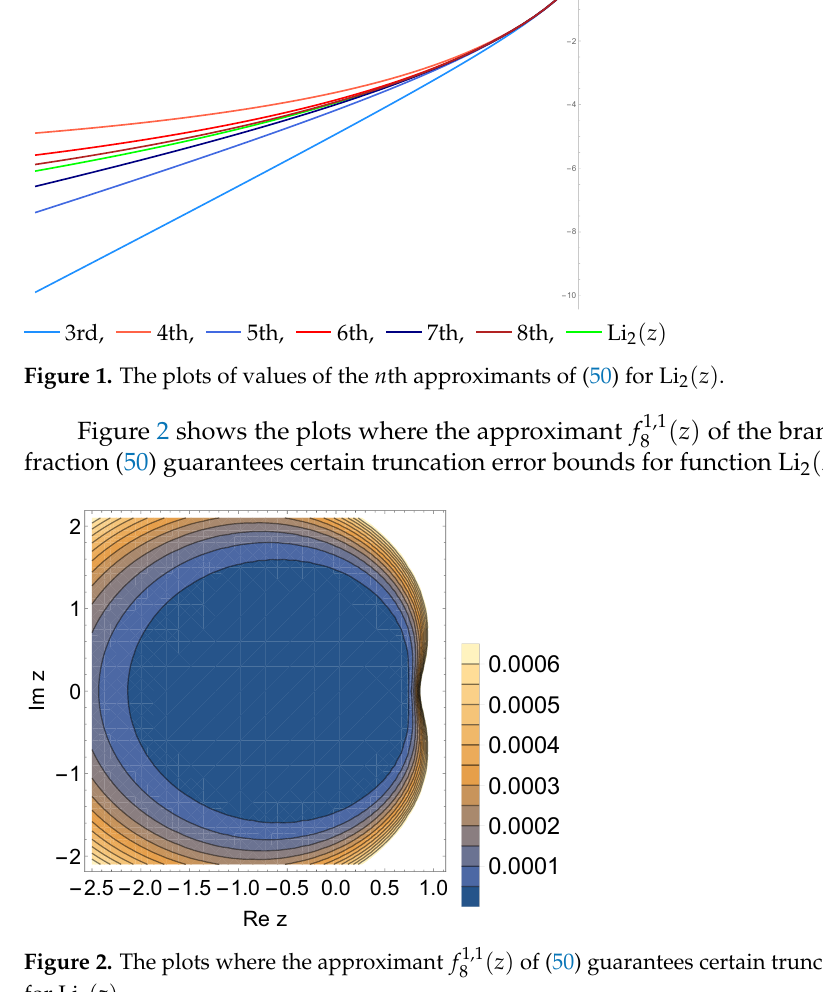
Figure 2. The plots where the approximant f 1,1 for Li 2 ( z )